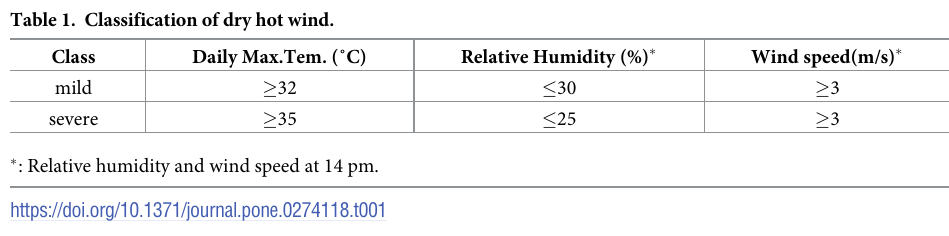
The experiment was carried out in one of the main wheat planting regions of Hebei Province. In addition, the phenotypic differences among varieties (including plant height, days of full growth period, panicle type, etc.) were also considered. The three tested winter wheat cultivars were Henong 6119 (HN6119), Gaoyou 5218 (GY5218), and Jimai 325 (JM325); the plant heights were 70.7 cm, 72.71 cm and 75 cm, respectively, and the days of the whole growth period were 239 days, 240 days and 242 days, respectively. The panicle types were spindle shaped, rectangular and nearly rectangular. There were 6 planting plots in this experiment for the three different cultivars, and the same cultivar was planted in every two plots. The planting plot of each variety was 2000 cm × 3000 cm in size, and each variety contained a replicate area with the same sowing time. Fertilizers (Shidanli compound fertilizer) were manually broad- casted before sowing and incorporated during basal application at rates of 389 kg ha -1 N, 75 kg ha -1 K and 55 kg ha -1 P. Fertilization, irrigation, pest control and other management practices were consistent across plots. The initial flowering date of the three tested wheat was May 3 rd , 2019, and there were no plant diseases or insect pests and no drought during the whole growth period. The categorization of DHW was performed according to Huo et al. [33] (shown in Table 1). A mild DHW occurred on May 22 nd , 2019, from 13:00 to 18:00, and a severe DHW occurred on May 23 rd , 2019, from 13:00 to 17:00. The field measurements were carried out from May 21 st to May 24 th and on May 28 th and May 31 st 2019, when the weather conditions were good. Table 2 gives the meteorological element values on DHW days in 2019.